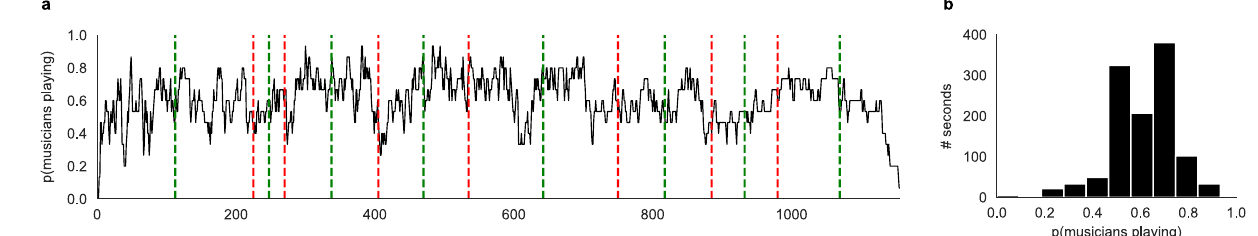
Figure 5. Musical actions at the group level. ( A ) The percentage of musicians playing at each second was estimated by averaging our musical action variable at each time point. ( B ) Histogram showing the distributions of the percentage of musicians playing at each second. Red dotted lines show the junctions between musical sequences, determined by the expert annotator. Green dotted lines show the middle of each musical sequence.